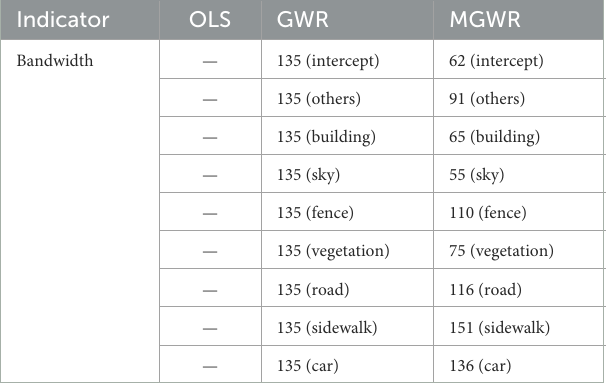
TABLE 6 Summary of model bandwidth